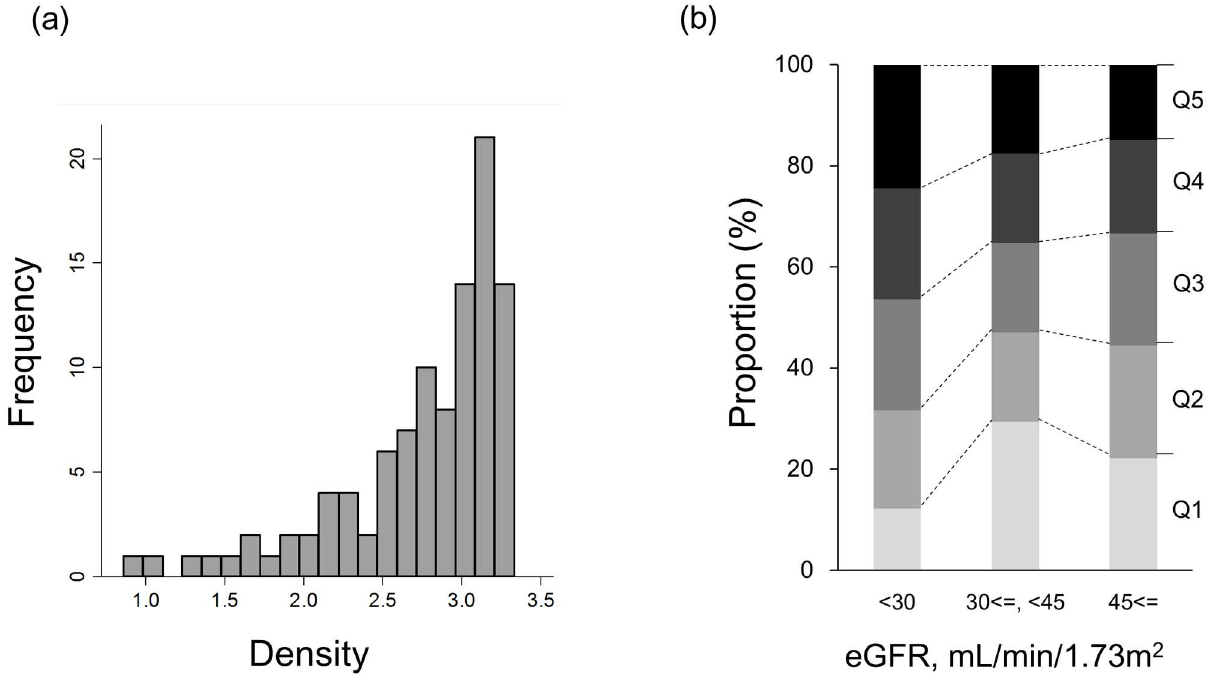
Fig 1. Distribution of the average density of coronary artery calcification in patients with chronic kidney disease. (a) histogram and (b) stacked bar charts accordingto CKD stages. Q1–Q5 denotes the 1st to 5th quintilesof the averagedensity of the coronary artery calcification. Range of quintilesfor the density: Q1, 0.86–2.36; Q2, 2.38–2.79;Q3, 2.81–3.04; Q4, 3.05–3.18;Q5, 3.18–3.33.